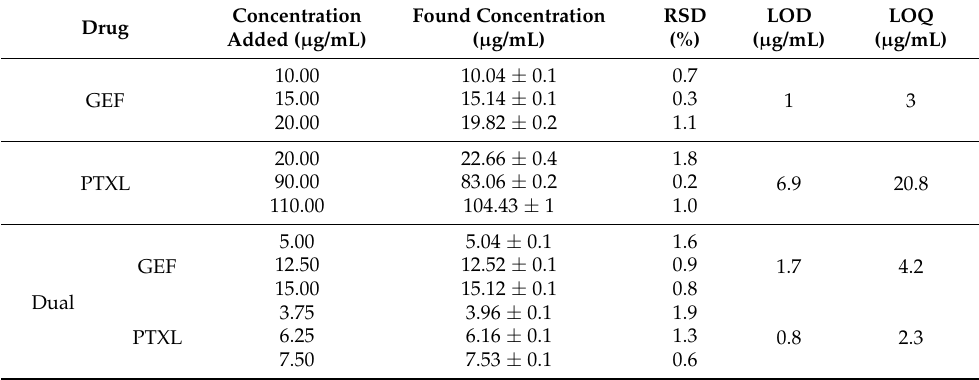
Table A5. Inter-day precision values, limit of detection (LOD) and limit of quantification (LOQ) of GEF, PTXL, dual-GEF, and